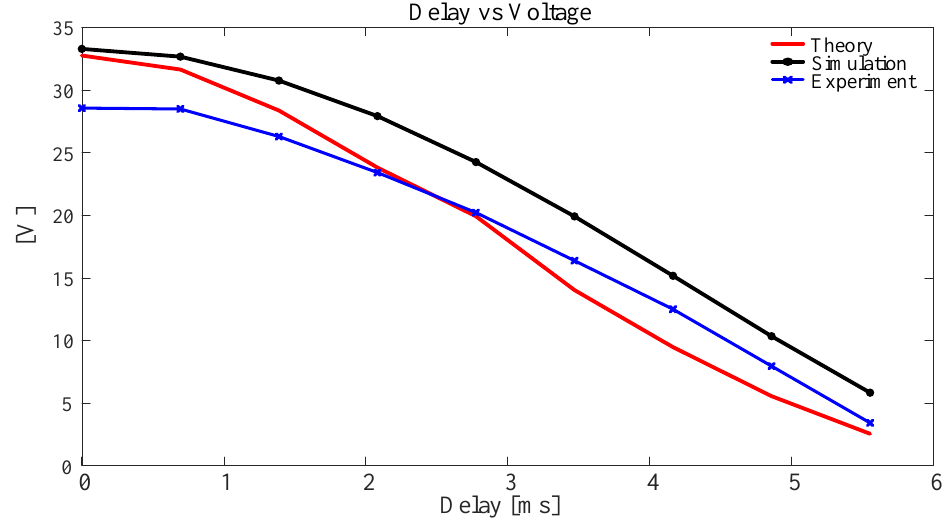
Figure 13. Firing angle delay vs. output